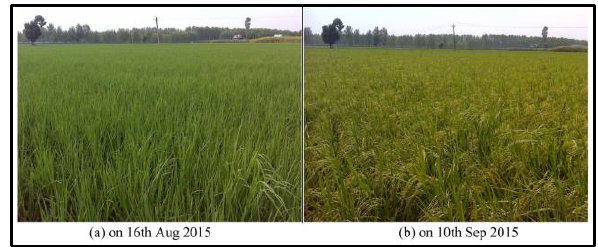
Figure 1. Ground-based photographs of a paddy field taken on